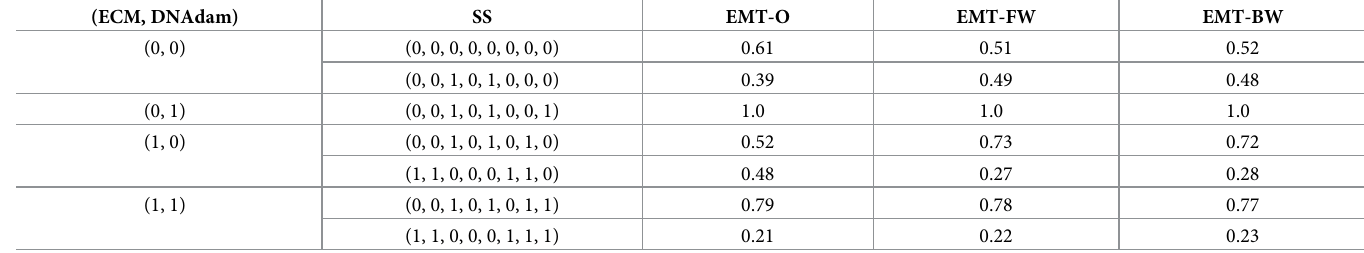
Table 6. Summary of the asynchronous updating results after 100 asynchronous updating simulations for each of the 256 possible initial states. The numbers on the right hand side are frequencies that the simulation reaches the corresponding steady state for the EMT model from [55], EMT-FW, and EMT-BW, respectively. The order of species is (NICD, Notch, TP53, TP63_TP73, miRNA, EMTreg, ECM,